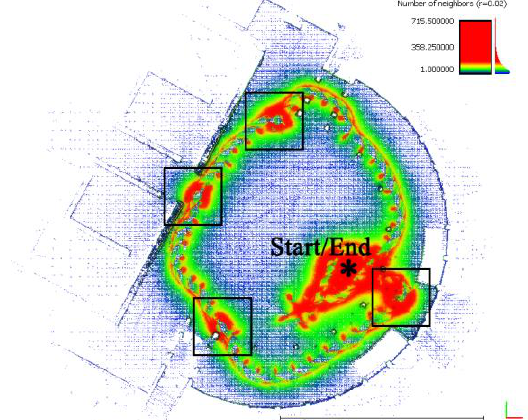
Figure 7. Density analysis of the Swift point cloud acquired in the apse. The analysis has been performed using CC (number of neighbour analysis, pts/V sphere r = 0.02 m). The black squares areas are the position of the spherical targets; area (*) is the starting point of the acquisition.